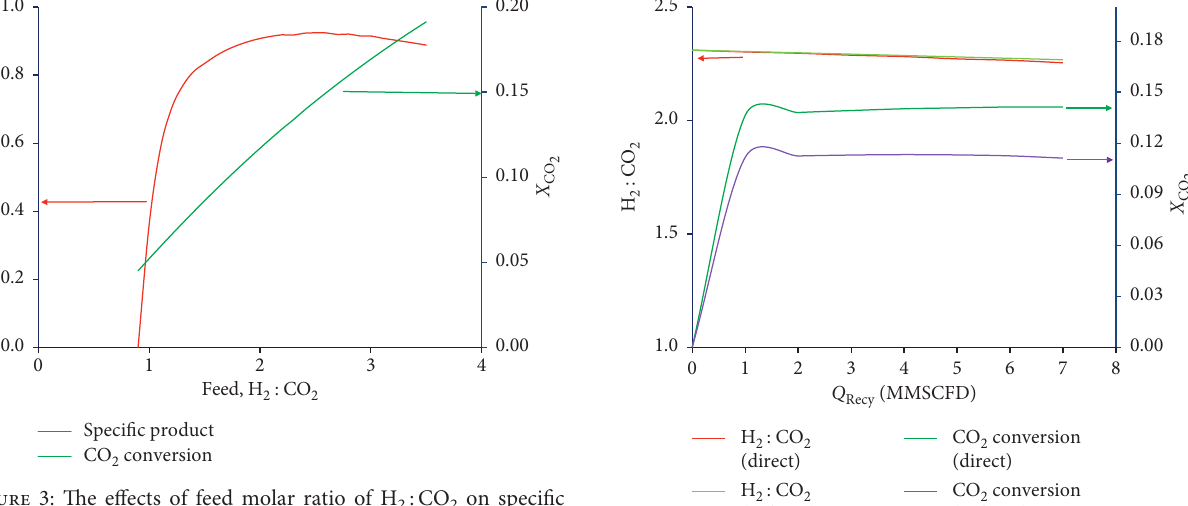
2 : CO 2 on specific . CO 2 Figure 4: Effects of unreacted recycle gas rates, Q direct and the direct processes on the H 2 : CO 2 ratio and CO 2 conversion, X . CO 2